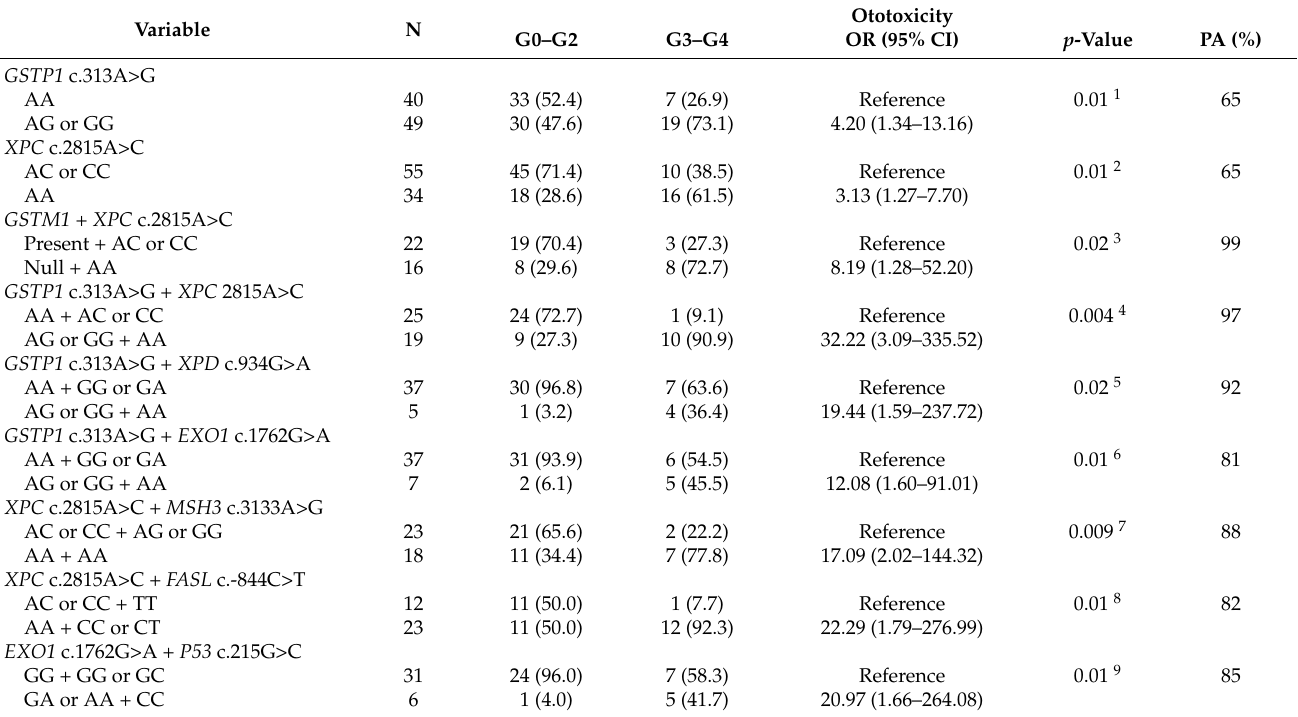
Table 5. Significant associations for single nucleotide variants and hearing impairment (according